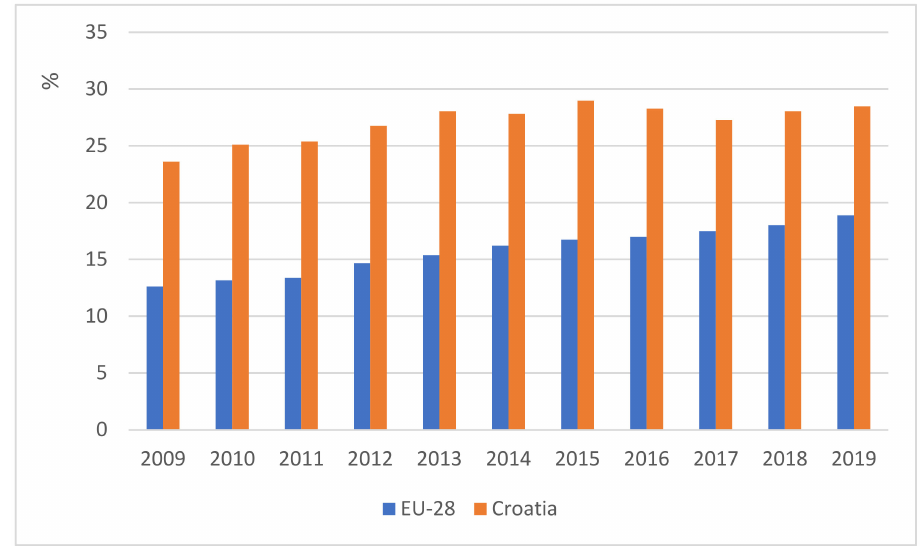
Figure 1. Overall share of energy from RES for EU-28 and Croatia, 2009–2019. Source: Authors’ elaboration based on